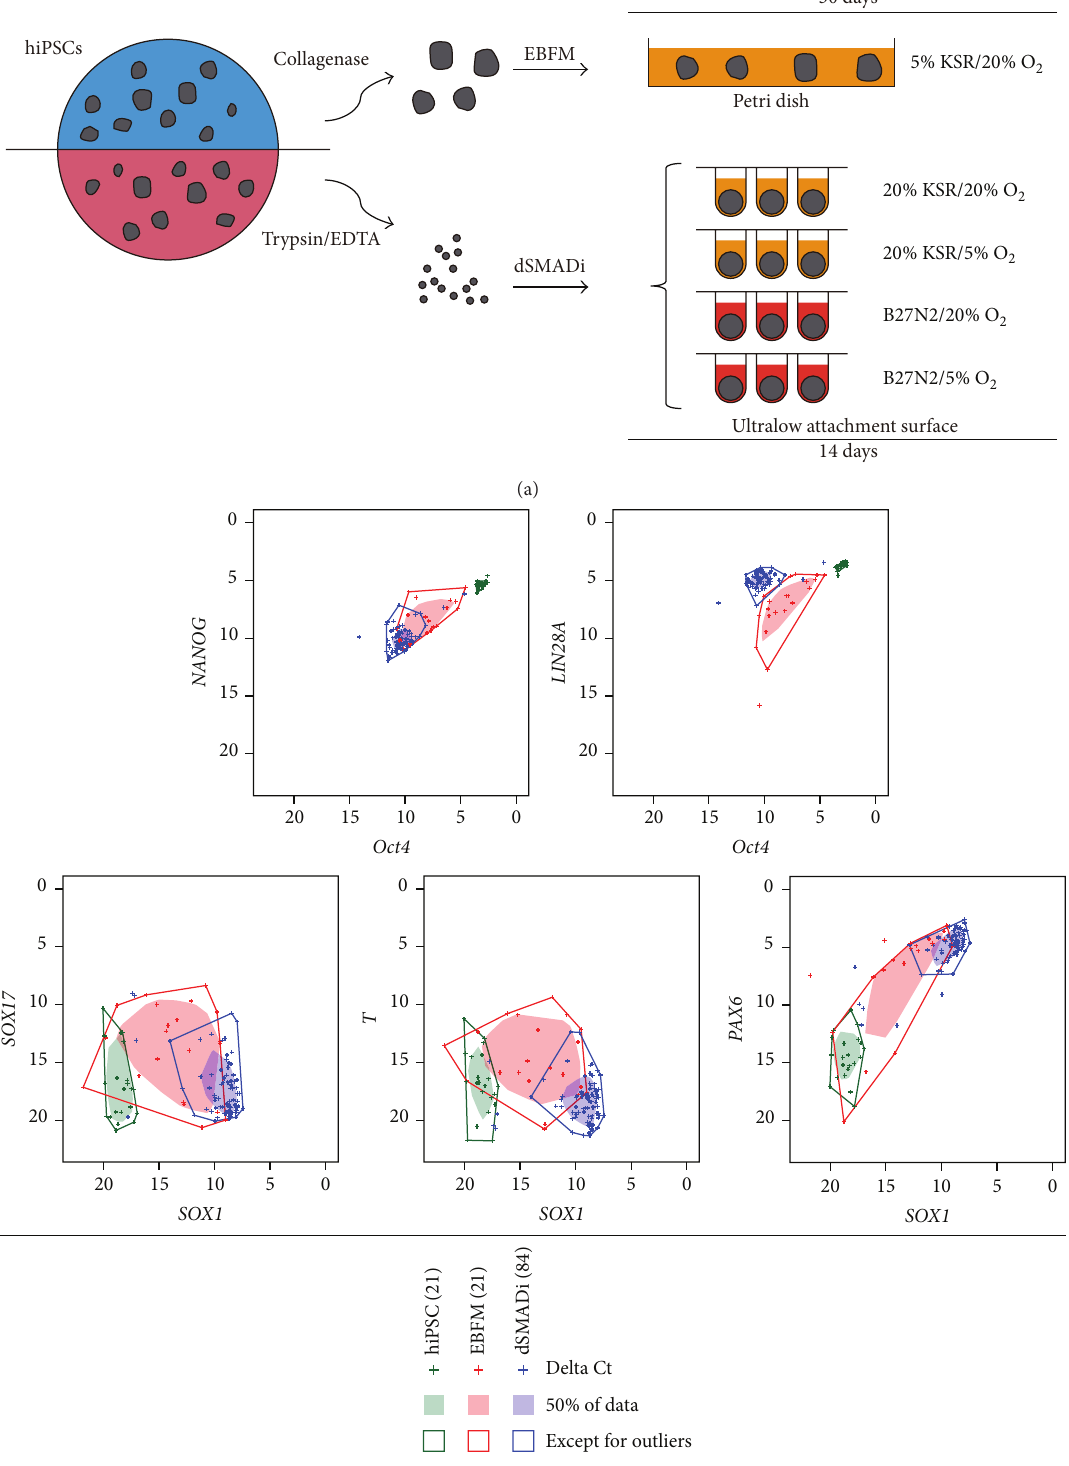
Figure 1: dSMADi improves the neural induction efficiency of hiPSCs regardless of their somatic tissue origin. (a) Schematic drawing of the neural induction methods used in this study. (b) Bivariate box plots displaying gene expression levels in hiPSCs, day 30 EBFM-derived EBs, and day 14 dSMADi-derived aggregates. Quantitative RT-PCR-generated delta Ct values for the pluripotency marker genes ( Oct4 , NANOG, and LIN28A ), endoderm marker gene ( SOX17 ), mesoderm marker gene ( T ), and neural marker genes ( SOX1 and PAX6 ) are shown. Green: hiPSCs; red: EBFM; blue: dSMADi. The numbers of clones analyzed are indicated in parentheses and “+” symbols represent each of the delta Ct values. Filled-in regions contain the 50% of the data points, and data points outside of the surrounding lines represent outliers. See also Figures S1 and